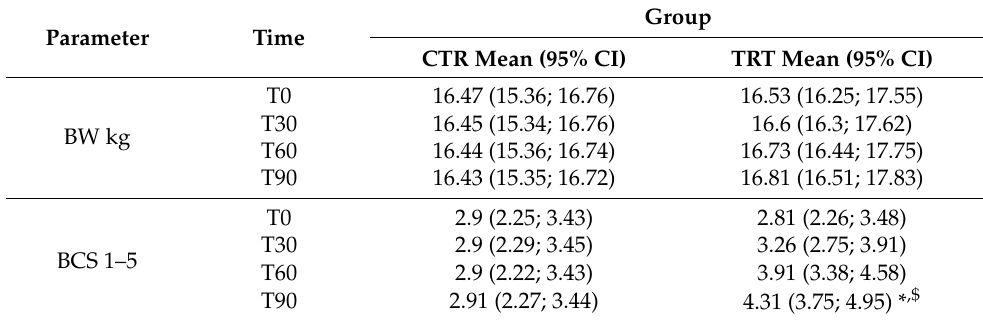
Table 2. Body weight (BW) and body condition score (BCS).